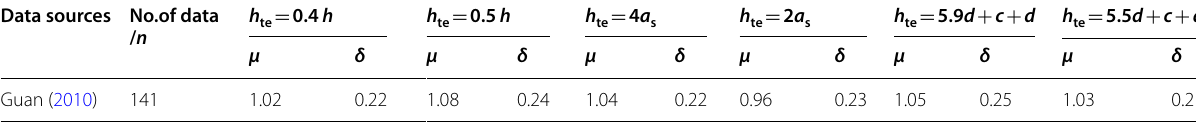
Table 9 Comparison results of w t max from RC beams with 335 MPa steel bars with w c1 max by the proposed methods. Data sources No.of data / n